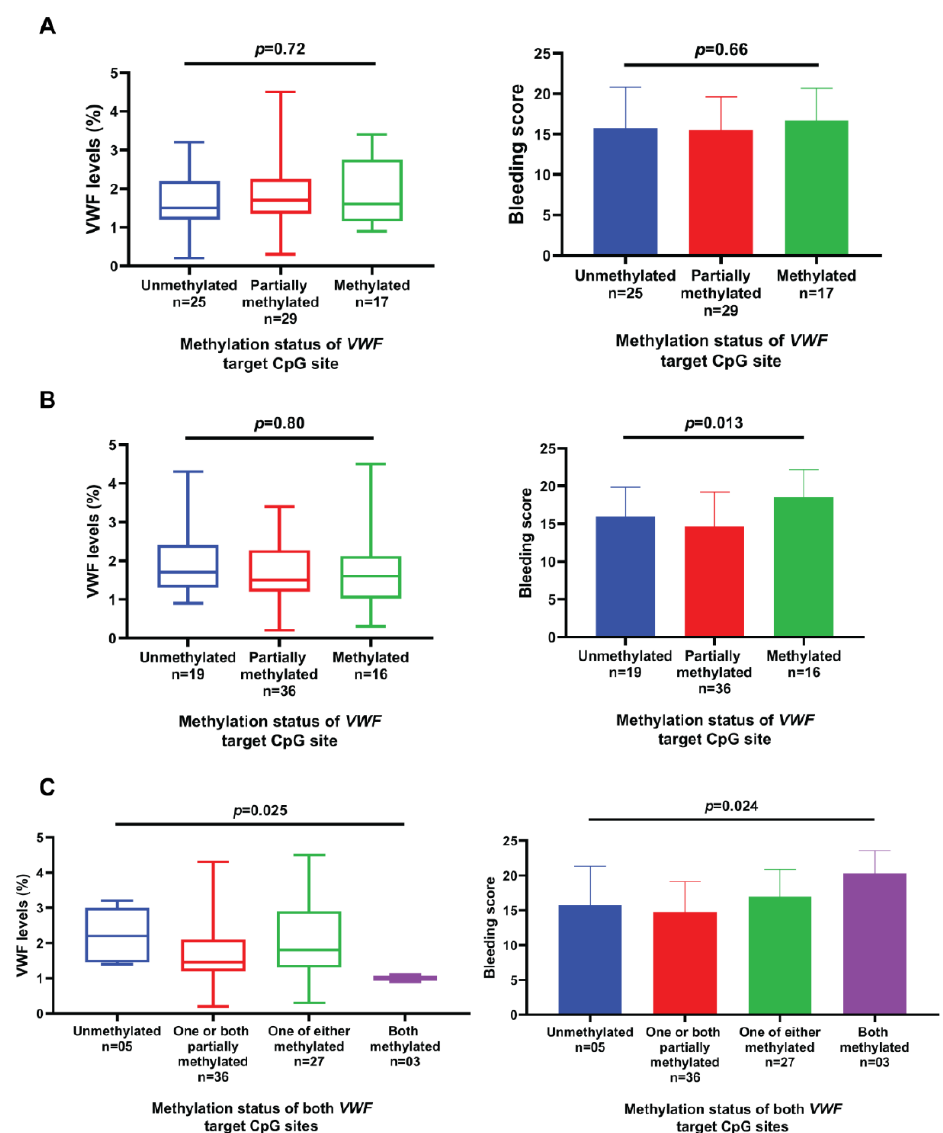
Figure 7. ( A ) VWF levels and mean bleeding score according to the DNA methylation status of VWF gene cg23551979 CpG site in Type III vWD patients. ( B ) VWF levels and mean bleeding score according to the DNA methylation status of VWF gene cg04053108 CpG site in Type III vWD patients. ( C ) VWF levels and mean bleeding score according to the combined DNA methylation status of VWF gene cg23551979 and cg04053108 CpG sites in type III vWD patients. The middle line of the box plot shows the median, the upper line of the box represents the 75th percentile, the lower line of the box represents the 25th percentile and the whisker below and above Q1 and Q4, respectively. The upper limit and whisker of blue, red, purple and green boxes represent the mean bleeding score and SD in patients having unmethylated, partially methylated and methylated CpG sites, respectively.